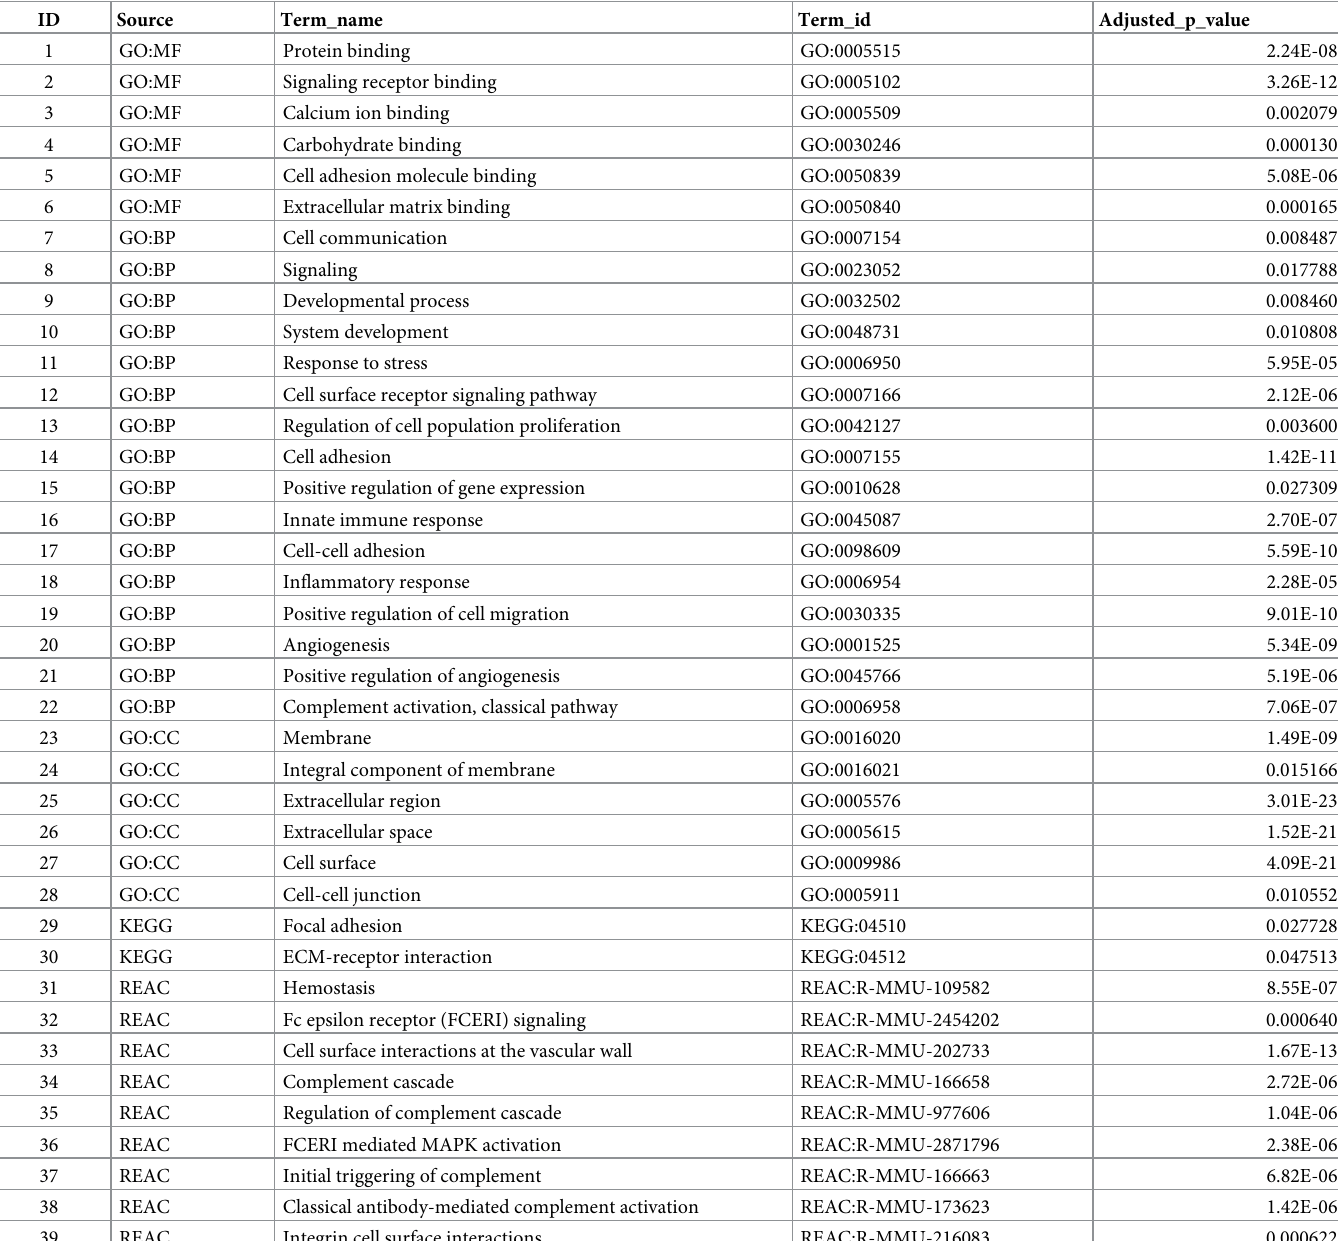
Table 3. Important terms obtained in gene ontology (GO) and pathway analyses via g:Profiler for 657 genes in 1242 transcriptswith � 2-folds changes and P- values �